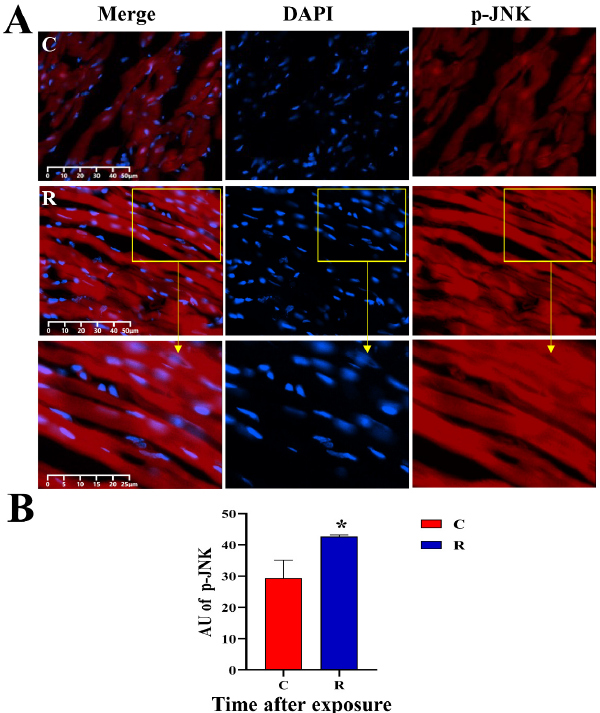
Figure 15. Changes in p-JNK expression and distribution of rats’ myocardium after S-band radiation. ( A ) Original graph of IF; ( B ) statistical analysis graph of AU. Significance signs were classified according to p -value: * p < 0.05. The yellow box is the magnified